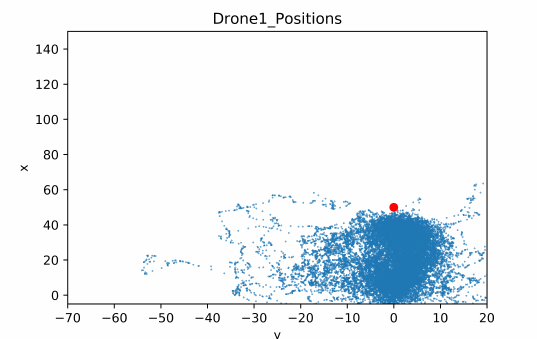
Figure 33. Drone Position Map for Case 1.4 by Transfer